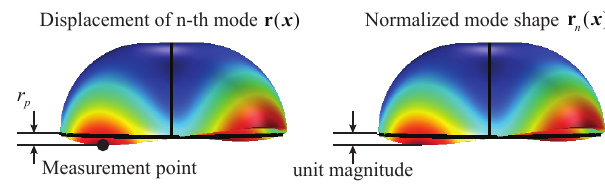
Figure 5. The normalization of an MHR with in-plane